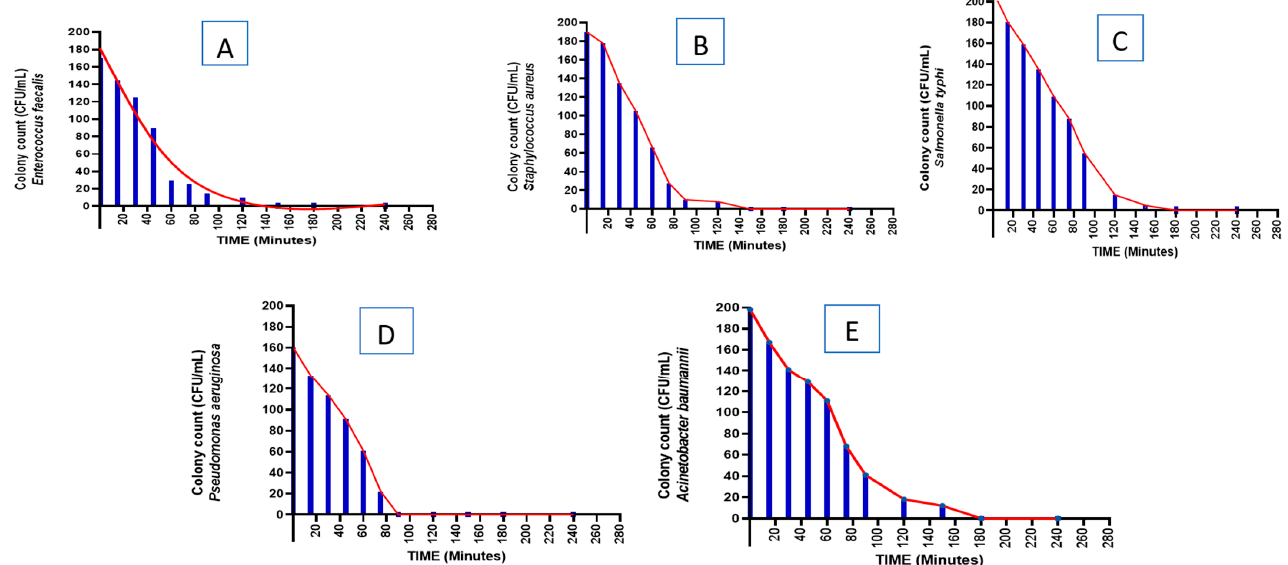
Figure 1. Time-kill experiment of ( A ) Enterococcus faecalis ; ( B ) Staphylococcus aureus; ( C ) Salmonella typhi ; ( D ) Pseudomonas aeruginosa ; ( E ) Acinetobacter baumannii. After 3 h, the relative viable count of each isolate was measured against aniseed extract and expressed as CFU/mL (% of the control). All bacteria were in the logarithmic phase at the beginning of the experiment, and aliquots were taken at 0, 0.5, 1, 1.5, 2, 3, 4, and 6. The viable colony counts on blood agar were determined as CFU/mL. Table 9. HPLC/MS analysis of aniseed